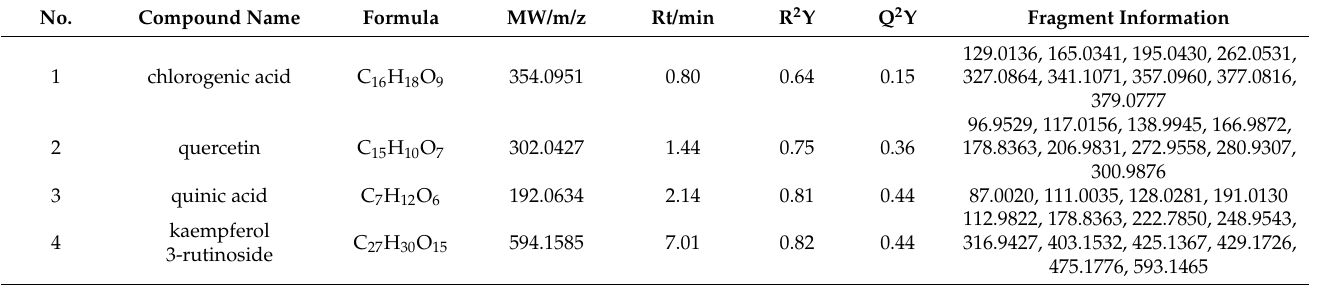
Table 6. Identification of chemical components of T. hemsleyanum metabolites associated with IL-1 β expression in the LPS-induced RAW264.7 inflammation